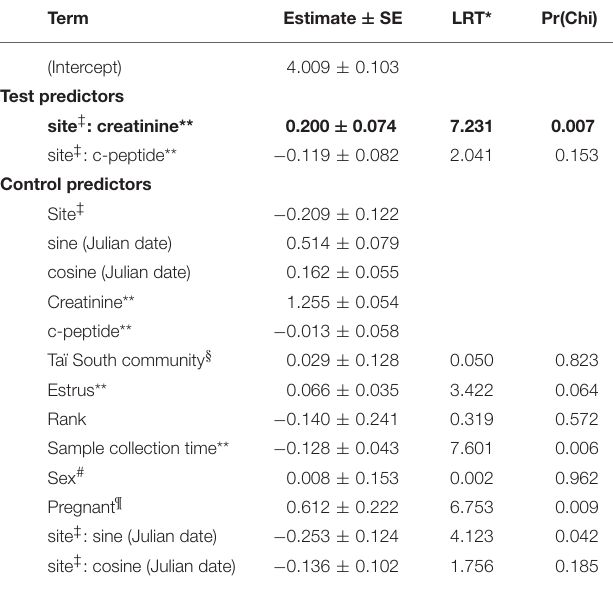
TABLE 2 | Model results for the effects of urinary creatinine and c-peptide on cortisol levels.